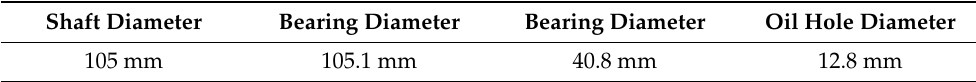
Table 1. Oil film size parameters.